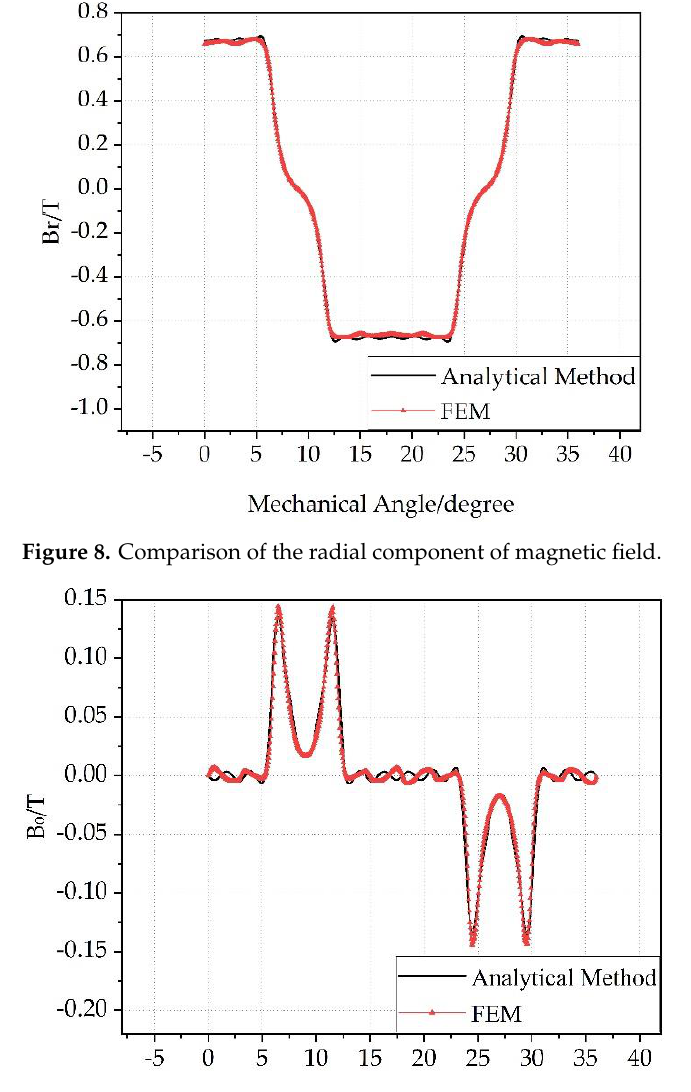
Figure 10. The process of conformal mapping.